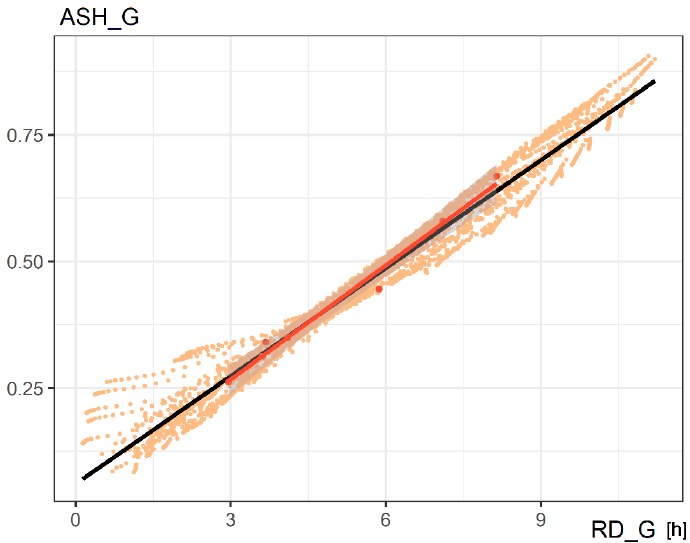
Figure 16. Linear regression function of ground-based L-metrics RD_G and ASH_G based on neighbourhood iterations (black line) and case studies (red line), including the 95% CI for the case studies regression line indicated by the grey area.